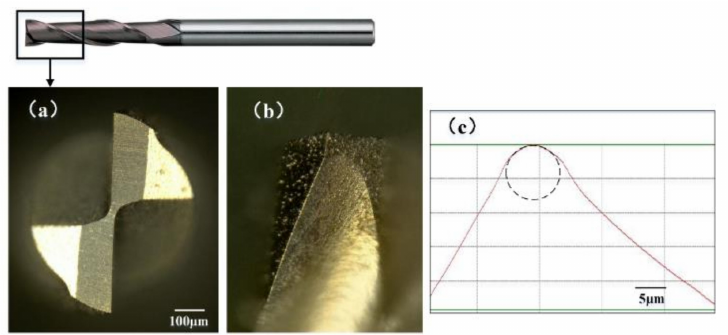
Figure 3. Micro end mill: ( a ) bottom view, ( b ) enlarged view, ( c ) cutting edge